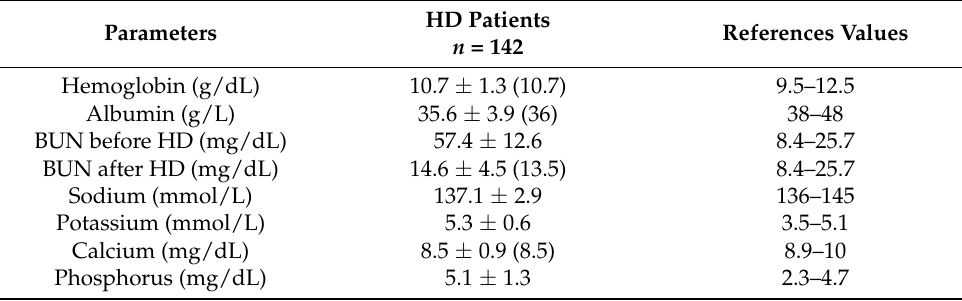
Table 2. Biochemical parameters in the HD